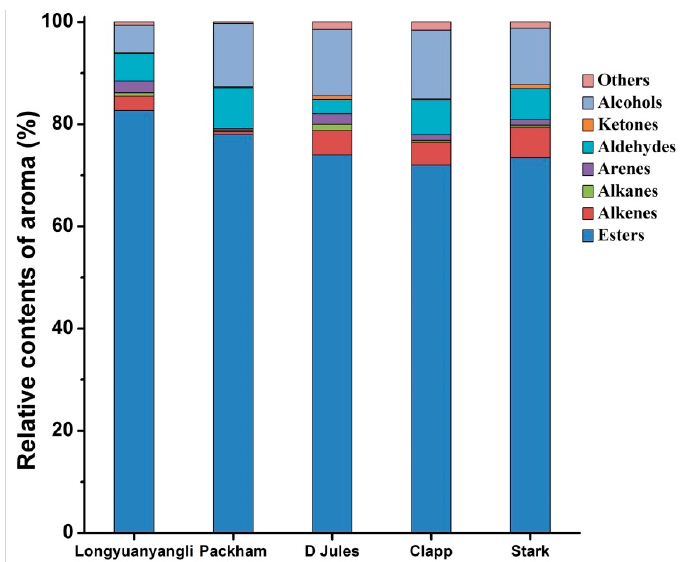
Figure 3. The number of chemical classes in pears.